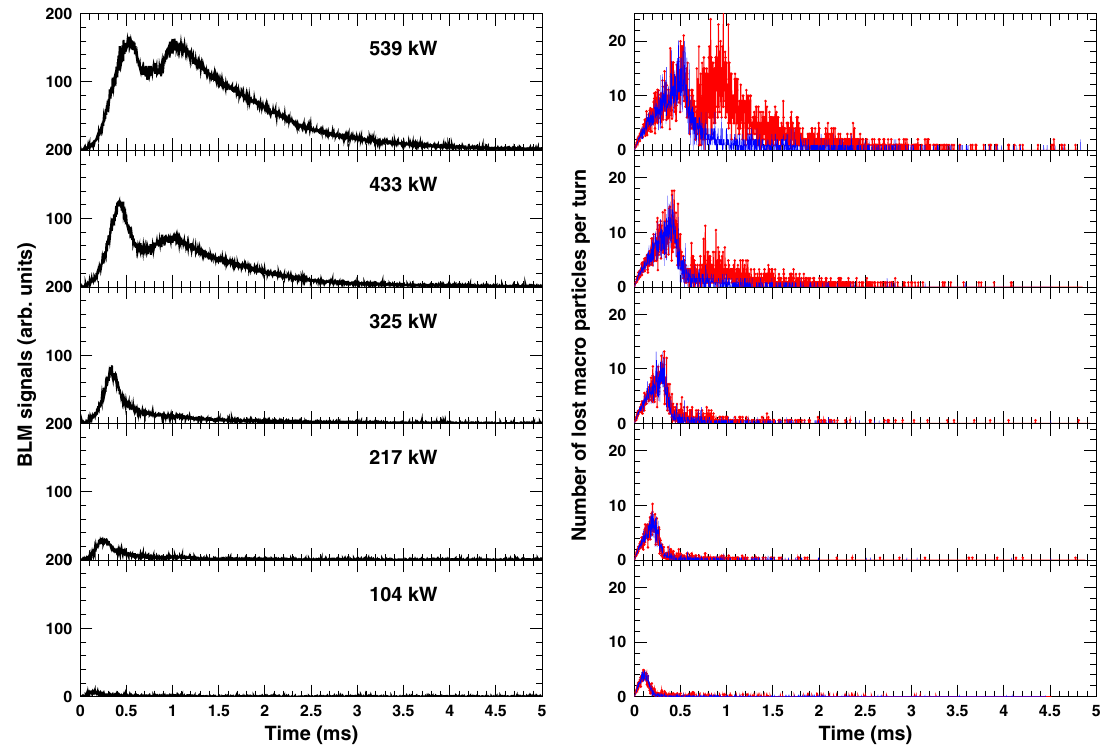
FIG. 12. (Left) Scintillation-type BLM signals for the first 5 ms measured at the collimator section with the injection painting parameter of ID 8 for various beam intensities from 104 to 539 kW. (Right) Corresponding numerical simulation results obtained with (red) and without (blue) the dipole field